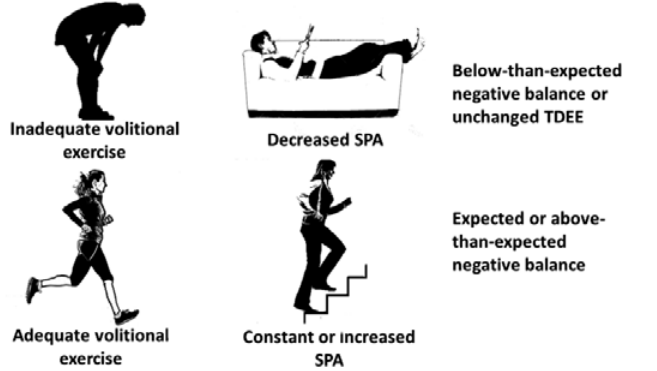
Figure 2. Possible interactions between volitional exercise, spontaneous physical activity (SPA), and the consequences for energy balance. This figure is an oversimplification of the compensatory events triggered by exercise, and only changes in SPA are showed. TDEE: total daily energy